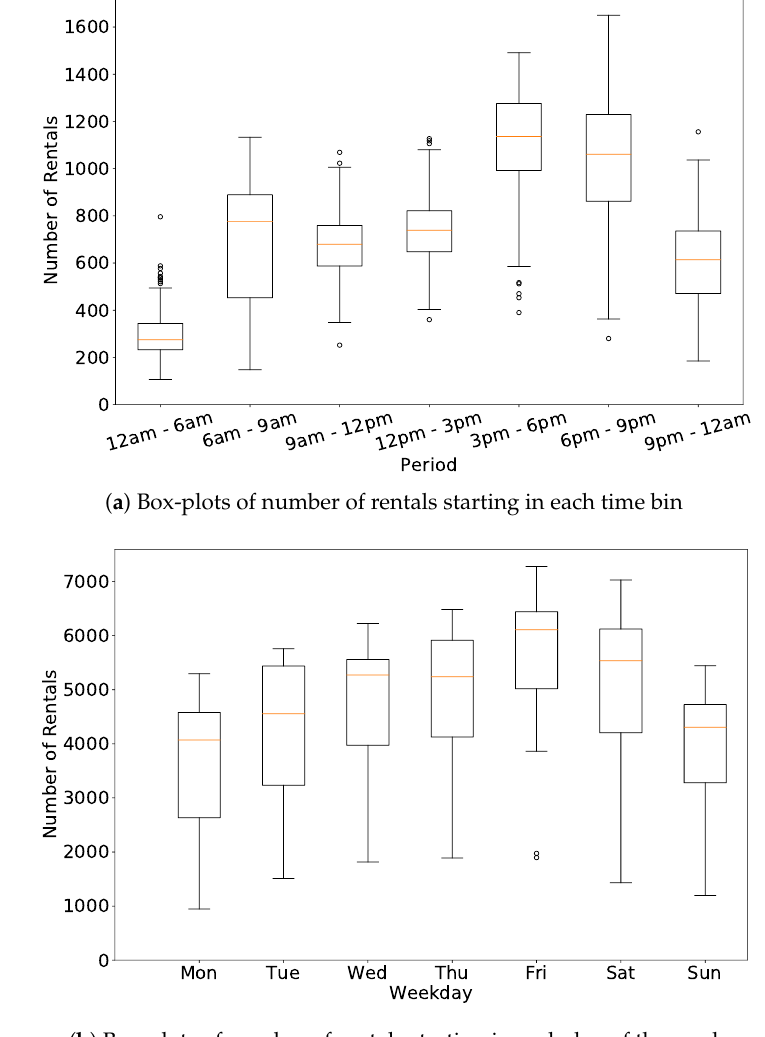
Figure 2. Temporal characterization of number of rentals. Box-plots highlighting the variability over the day for the same time bin of the day (top plots), and over different days (bottom